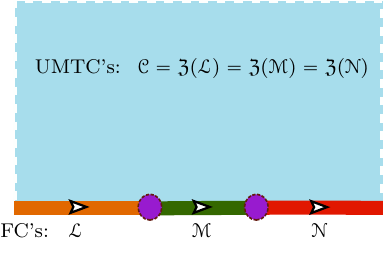
Figure 1 . This picture depicts a 2d topological order p C ; 0 q , where C is a UMTC, with three gapped edges given by UFC’s L ; M ; N . The 2d bulk is oriented as the usual R 2 with the normal direction pointing out of the paper in readers’ direction. The arrows indicate the induced orientation on the